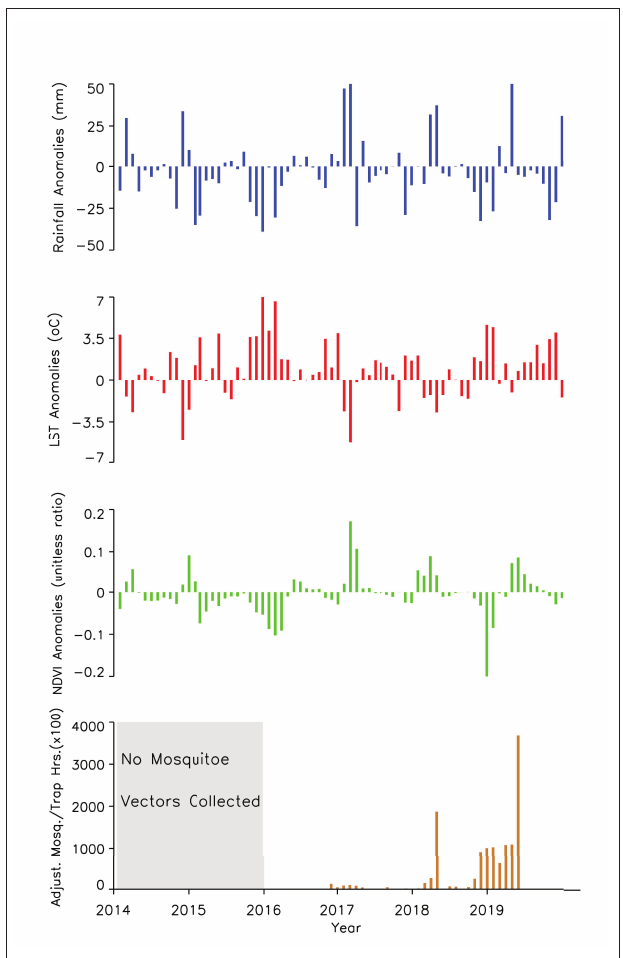
FIGURE 8 | Time series measurements of rainfall, land surface temperatures, normalized difference vegetation index anomalies, and adjusted mosquito vector collections during the study period. Vector collections only became prominent when rainfall and NDVI were trending toward above normal during the growing seasons from 2017–2019.